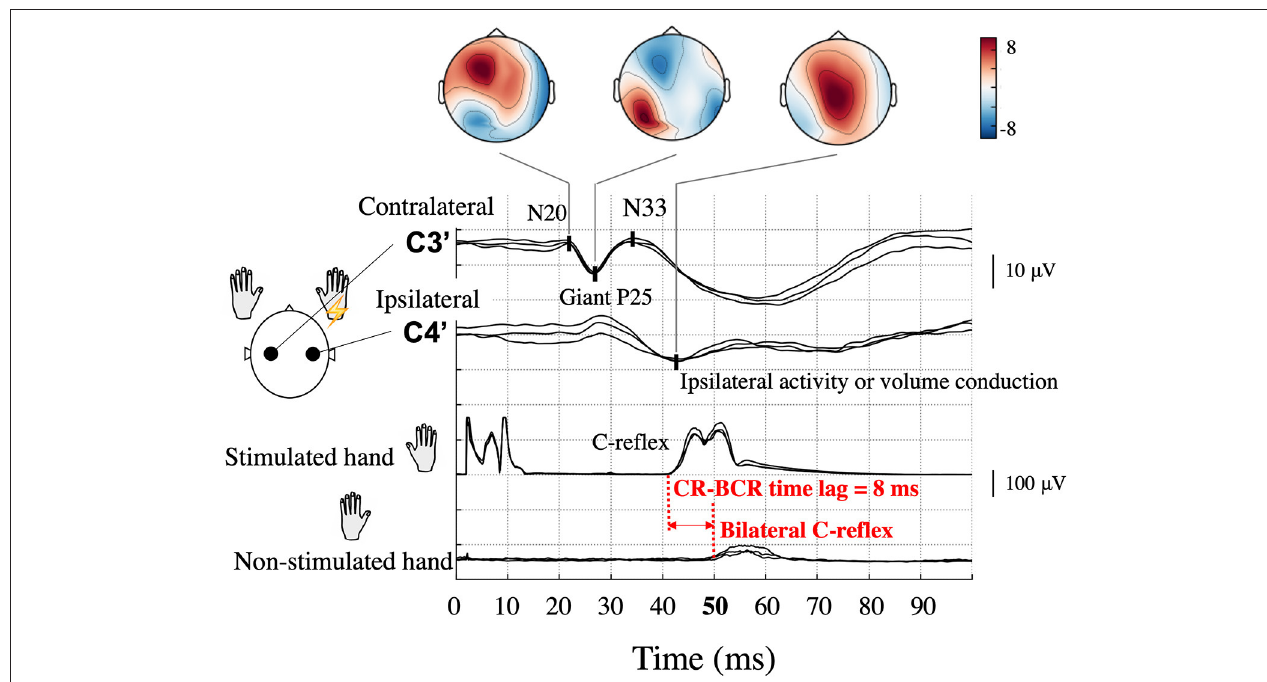
FIGURE 1 | Typical somatosensory-evoked potential and electromyography recordings following right median nerve stimulation in a patient (Patient 2) with bilateral C-reflex (BCR). High amplitude P25-N33 components (giant P25) are prominent at the contralateral hand sensory area (C3 ′ ) electrode, and similar potentials can be observed at the corresponding ipsilateral electrode (C4 ′ ). Topographical maps are shown according to components. Ipsilateral activity is unreliable because of interference from the contralateral giant component. The onset of the C-reflex (CR), which is shown in the stimulated hand, was 42ms, whereas that of the BCR in the non-stimulated hand was 50ms; thus, the CR-BCR time lag was